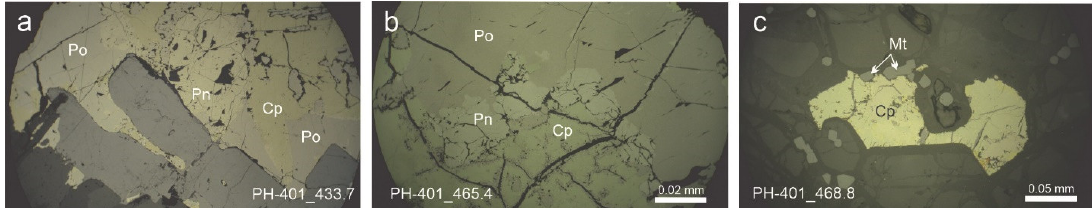
Figure 7. Microparageneses of the minerals in the olivine gabbro-dolerite: ( a , b ) pyrrhotite-pentlandite-chalcopyrite aggregates; ( c ) chalcopyrite grain in intergrowth with magnetite (Mt). Contact gabbro-dolerite is found in most boreholes at the contact of the intrusion with the host rocks in the form of layers 0.3–5-m thick; the greatest thickness of these rocks (up to 10 m) has been identified in boreholes PH-222 and PH-72. Low contents of ore elements (about 5 ppm in PH-72 and PH-133 and less than 1 ppm of PGEs in other boreholes) are observed in contact gabbro-dolerites. These horizons are characterized by schliere-disseminated sulfide mineralizations of pyrrhotite,